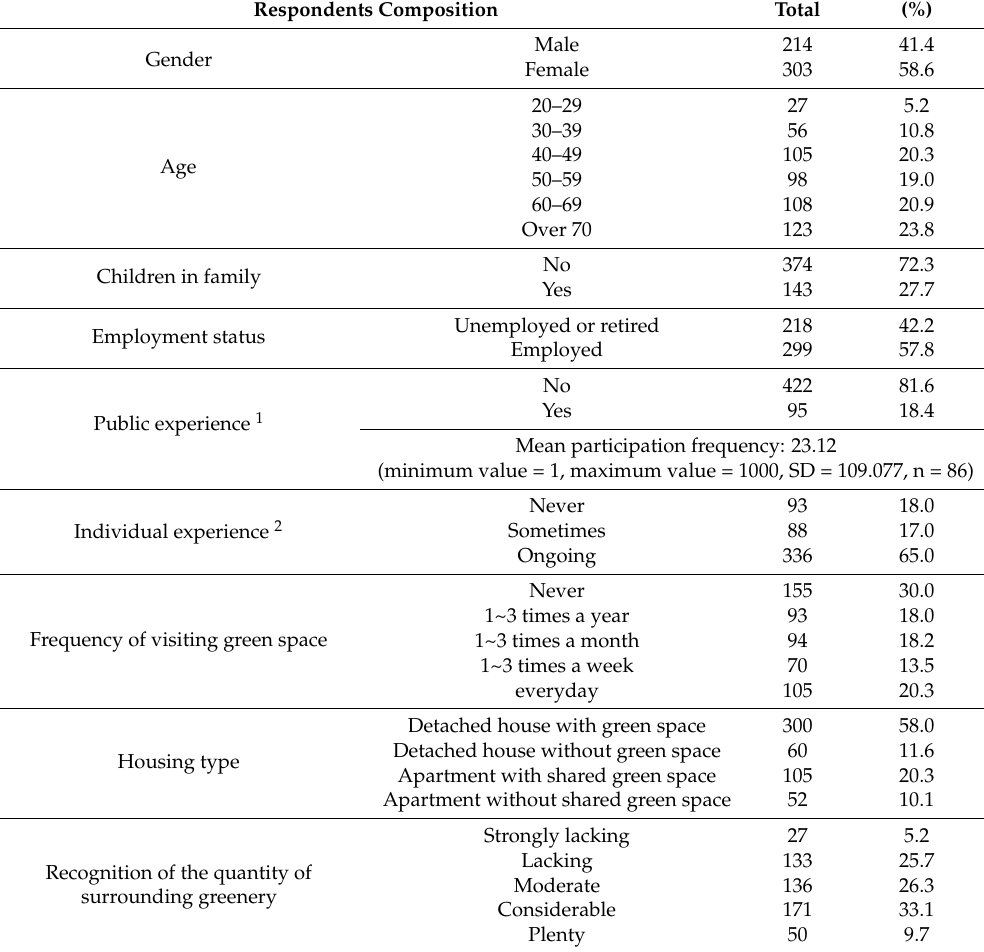
Table 2. Respondents composition (n =